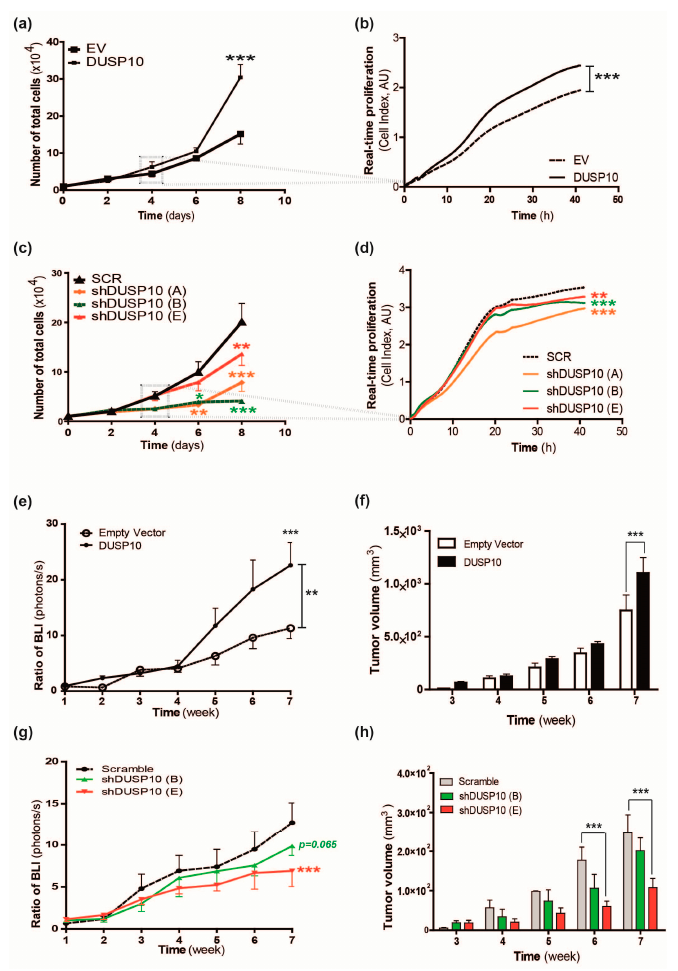
Figure 1. Dual-specificity phosphatase 10 (DUSP10) expression promotes higher colorectal cancer (CRC) cell proliferation and in vivo tumor growth. ( a ) Total cell number of HT29lucD6-DUSP10 was normalized to HT29lucD6-EV. Two-way ANOVA followed by Bonferroni’s post-test (mean ± standard error of mean (SEM); *** p < 0.001) and eight independent experiments were performed. ( b ) Growth curves of HT29lucD6-EV and HT29lucD6-DUSP10 for 42 h using real-time proliferation analysis by xCELLigence technology. Linear regression analysis was performed (*** p < 0.001). Representative graph of six independent experiments. ( c ) Total cell number of HT29lucD6-shDUSP10 cell lines was normalized to HT29lucD6-SCR. Two-way ANOVA followed by Bonferroni’s post-test (mean ± SEM; * p < 0.05, ** p < 0.01, *** p < 0.001) and seven independent experiments were performed. ( d ) Growth curves of HT29lucD6-shDUSP10 and HT29lucD6-SCR for 42 h using real-time proliferation analysis by xCELLigence technology. Linear regression analysis was performed (** p < 0.01, *** p < 0.001). Representative graph of three independent experiments. ( e ) Bioluminescence imaging (BLI) of mice xenoinjected with HT29lucD6-DUSP10 and HT29lucD6-EV. Data was normalized to first week post-inoculation for each cell line. Two-way ANOVA followed by Bonferroni’s multiple comparison and linear regression analysis were performed (mean ± SEM; p < 0.05; 7–8 mice per group). ( f ) Tumor volume of HT29lucD6-DUSP10 and HT29lucD6-EV xenografts was measured for seven weeks. Two-way ANOVA followed by Bonferroni’s multiple comparison tests were performed (mean ± SEM; p < 0.05; five mice per group). ( g ) BLI of mice xenoinjected with HT29lucD6-shDUSP10 and HT29lucD6-SCR. Two-way ANOVA with Bonferroni’s multiple comparison test and linear regression analysis were performed (mean ± SEM; *** p < 0.001; eight mice per group). ( h ) Tumor volume of HT29lucD6-shDUSP10 and HT29lucD6-SCR xenografts was measured for seven weeks. Two-way ANOVA and Bonferroni’s multiple comparison test were performed (mean ± SEM; *** p < 0.001; four mice per